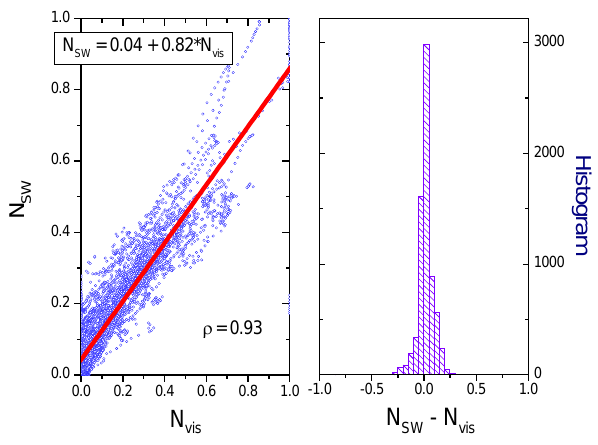
Fig. 7 . The visible versus shortwave fractional sky cover (left) and the Fig. 7. The visible versus shortwave fractional sky cover (left) and corresponding difference (right) for the selected 13 cloudy days. the corresponding difference (right) for the selected 13 cloudy